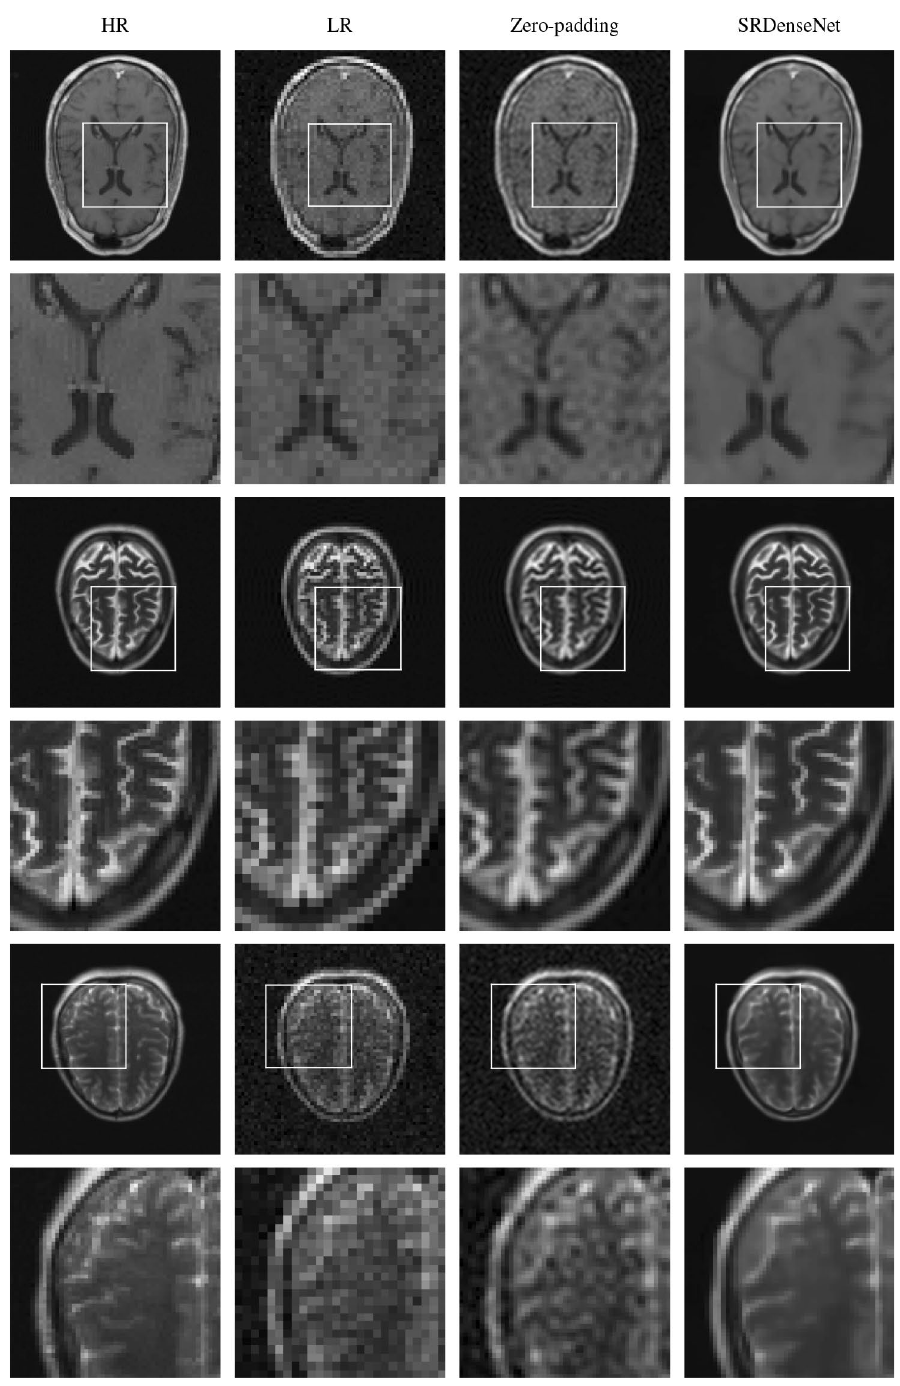
Figure 4. In the first column, we have three different HR images (which are high-field MR images from the database) from our test set. These HR images are our reference images, i.e., in an ideal scenario, the network would generate these exact images. The first, third and fifth rows show the full images, in the second, fourth and sixth rows we find zoomed-in versions of patches of the images in the first, third and fifth rows. The second column shows the noisy LR images corresponding to the HR images in the first column. These images are fed into the trained convolutional neural network. The third column shows the SR images obtained by zero-padding k-space, and in the fourth column, we see SR images obtained by applying